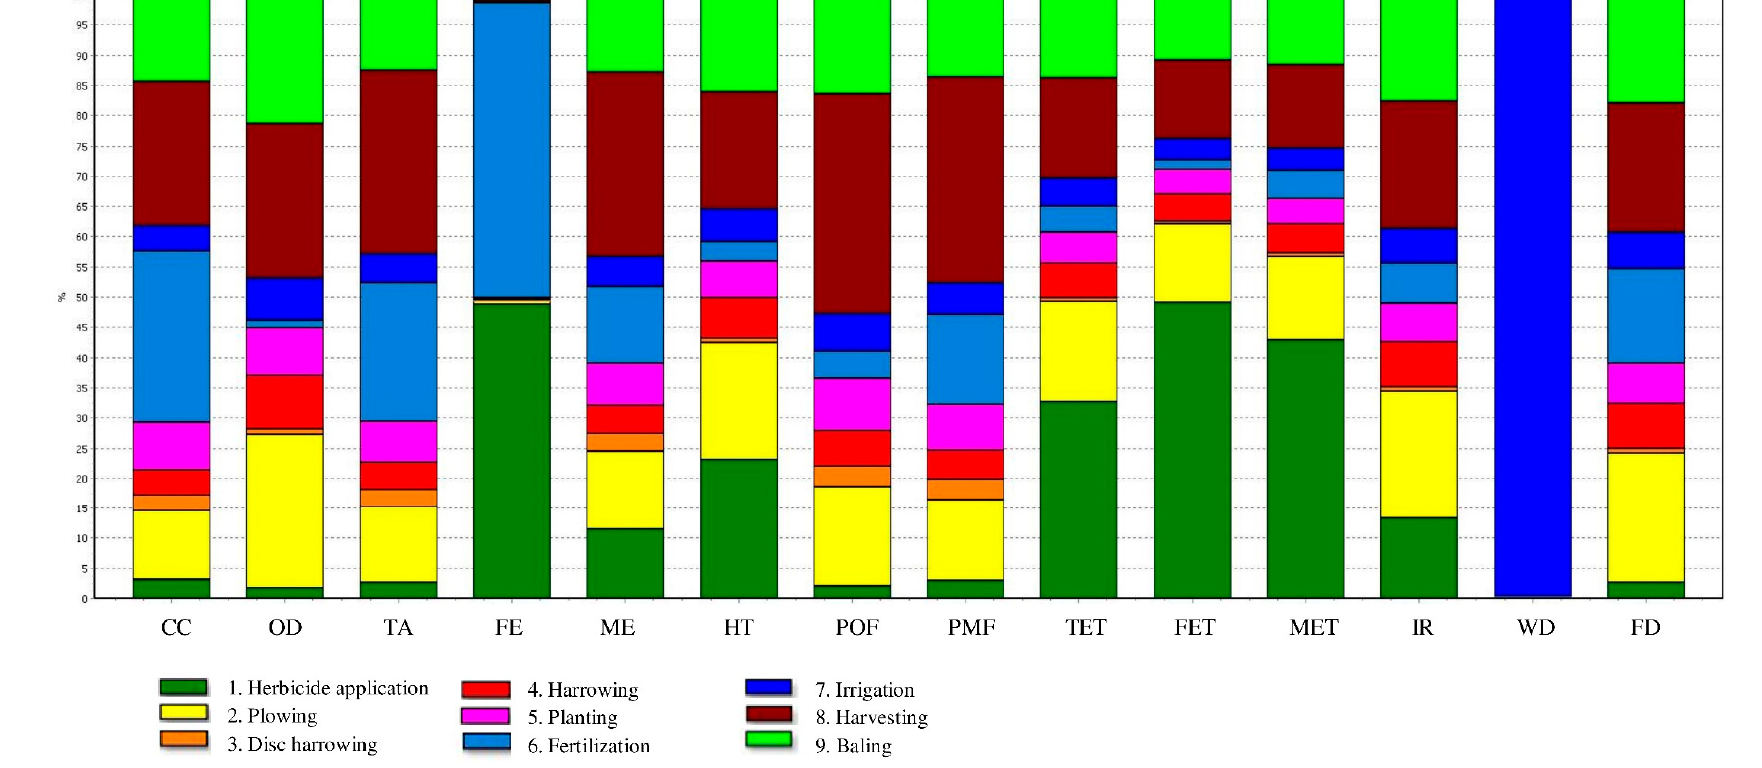
Figure 2. LCIA for Miscanthus field